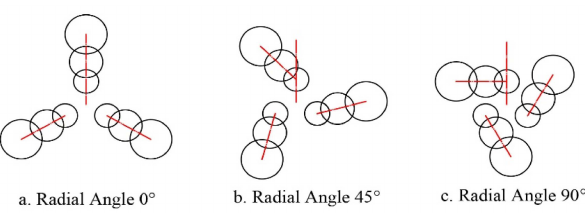
Figure 2. Structural diagram of the self-propelled nozzle.